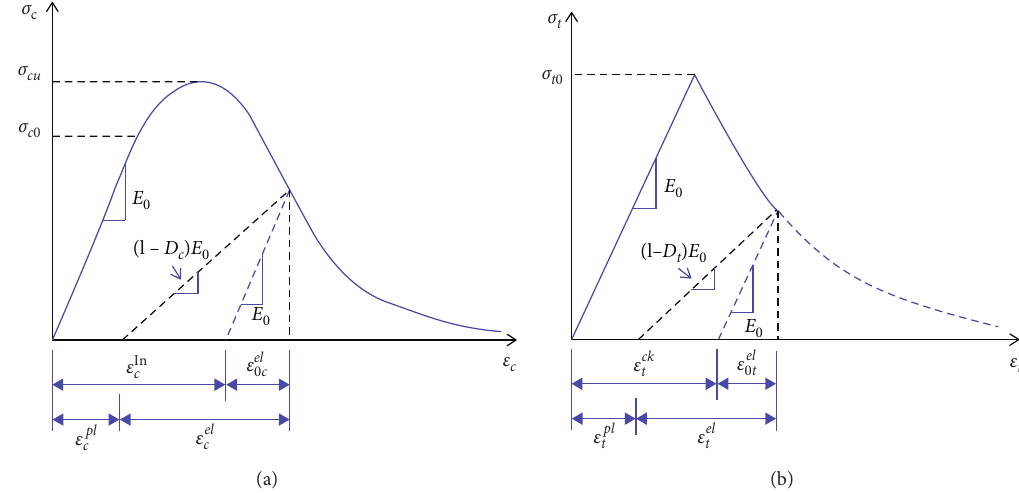
Figure 5: CDP model of concrete material [20]. (a) Compressive behavior. (b) Tensile